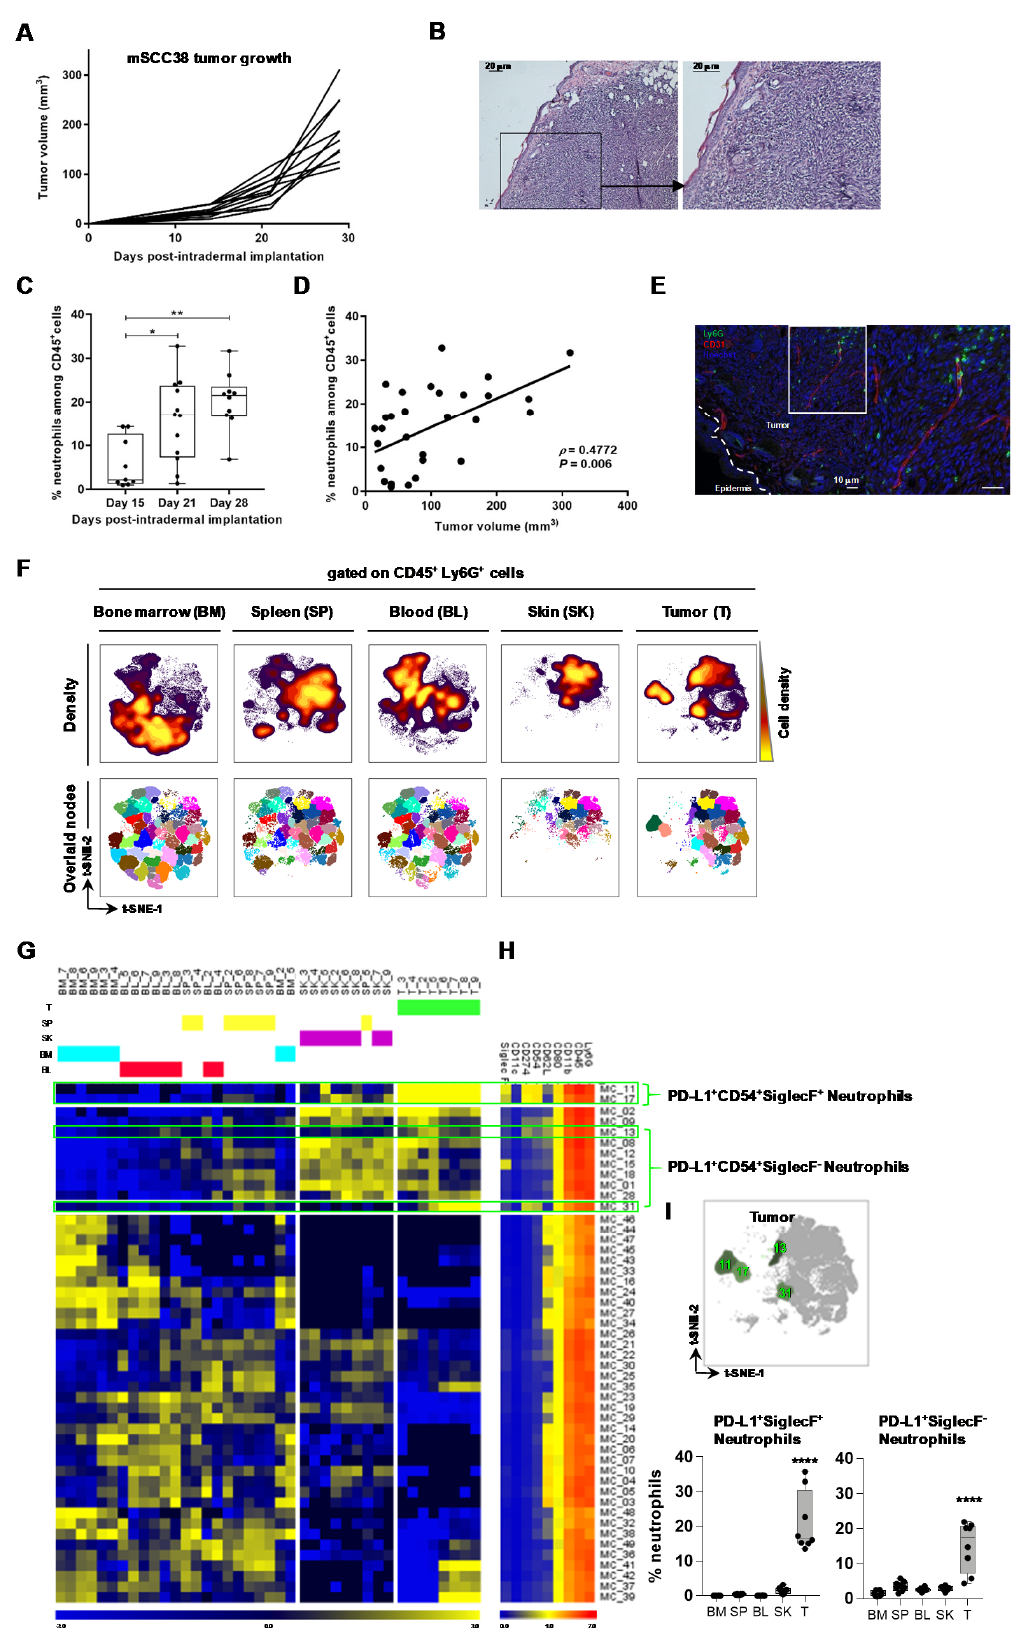
Figure 2. Characterization of TANs (tumor-associated neutrophils) infiltrating mSCC38 tumors. ( A ) Growth kinetic of mSCC38 grafted intradermally in FVB/N mice ( n = 10 mice). ( B ) Representative hematoxylin-eosin staining of a frozen section, scale bar: 20 μm. ( C ) Proportion of TANs in mSCC38 tumors ( n = 9–12, from three independent experiments), * p < 0.05, ** p < 0.01, Kruskal–Wallis one-way ANOVA. ( D ) Correlation between the frequency of infiltrating Ly6G + TANs and tumor volume ( n = 31). Linear regression curve, spearman r value, and p value (95% confidence interval) are shown. ( E ) Representative immunofluorescence imaging of frozen sections of mSCC38 tumor at day 30 post-